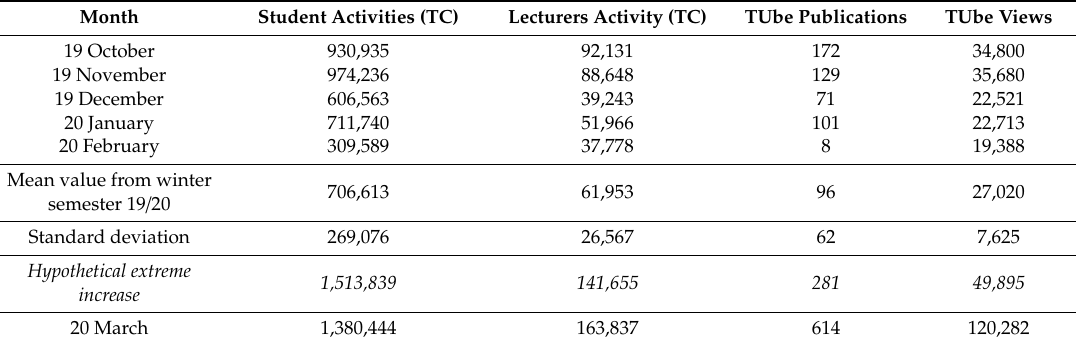
Table 4. Monthly activities of students and lecturers in the winter semester 2019 / 2020, and an estimation of a hypothetical extreme increase and real data for March 2020. Source: Graz University of Technology, Educational Technology. Note: The “hypothetical extreme increase” was calculated as a mean value plus 3 standard